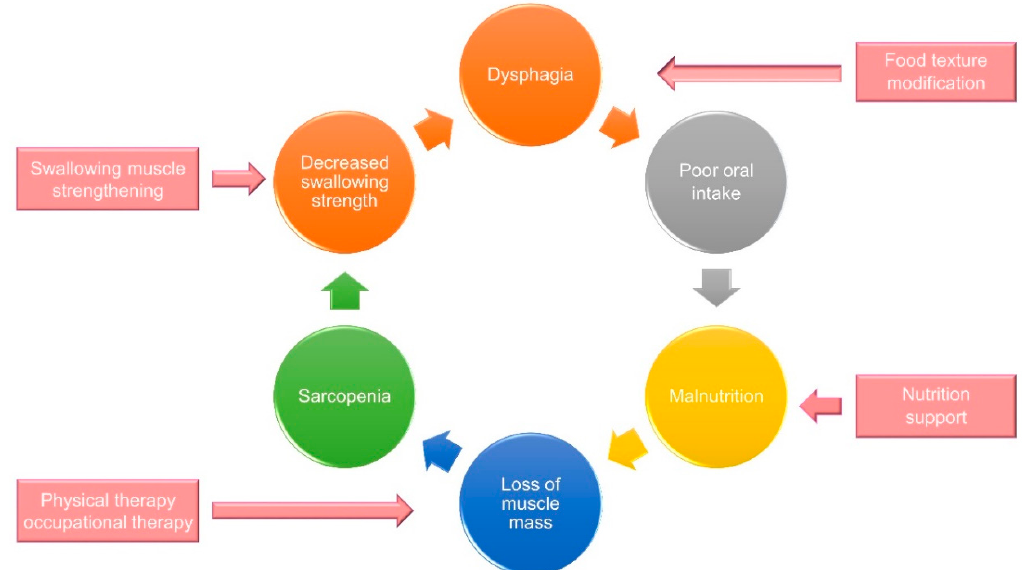
Figure 10. A multidisciplinary intervention strategy to break the vicious circle between sarcopenic dysphagia and malnu- trition.